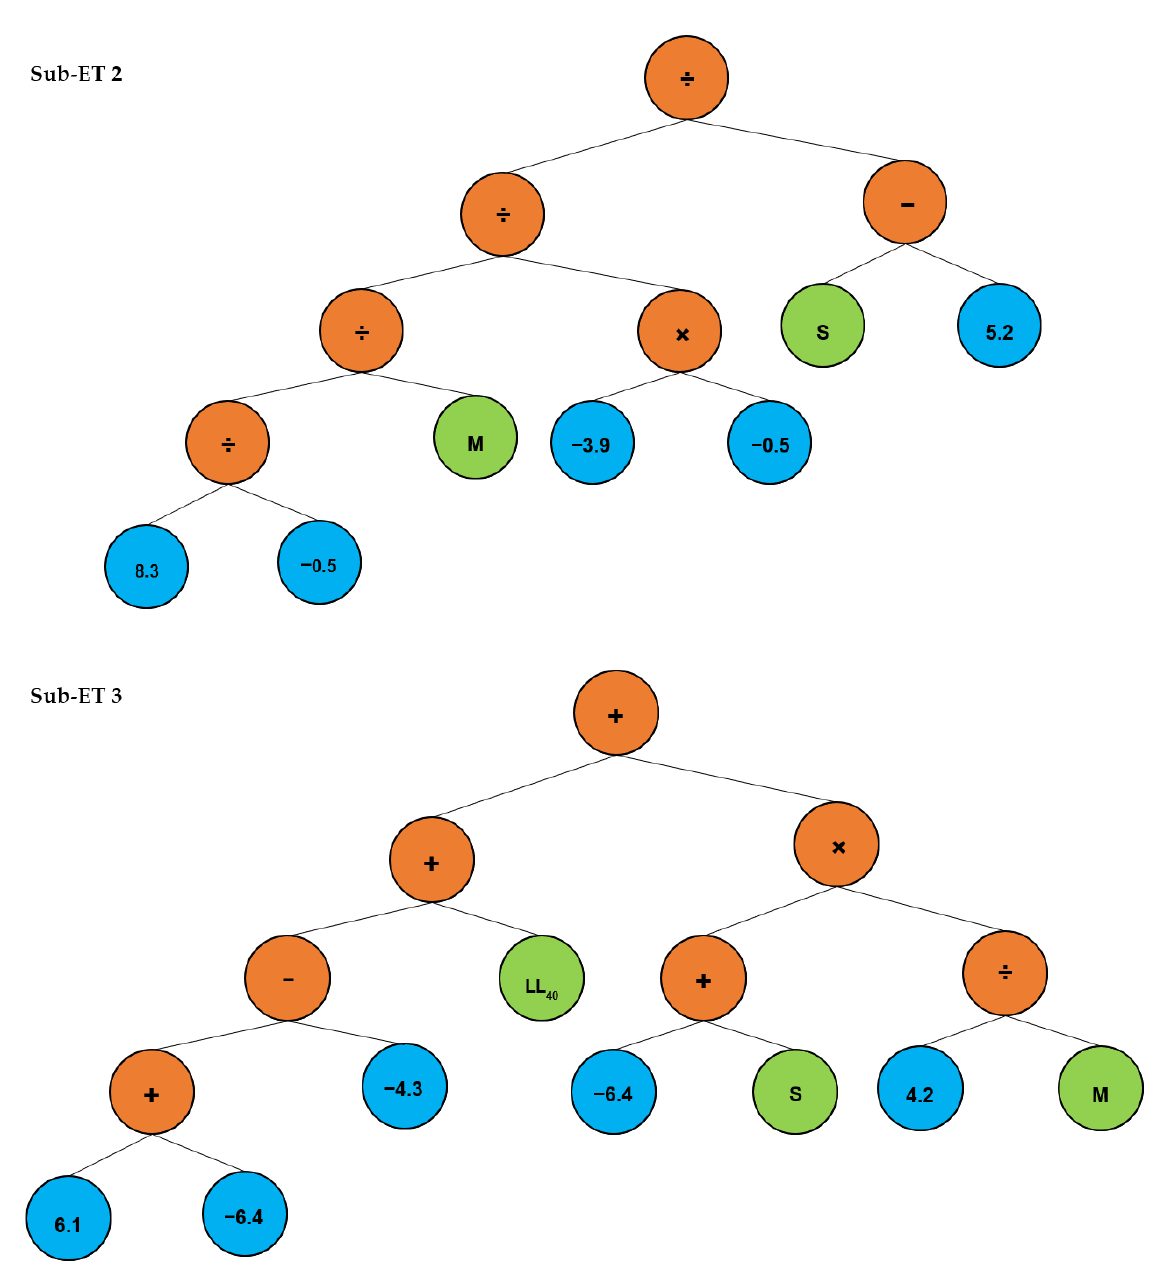
Figure 5. Expression trees [ETs] were developed using gene expression programming